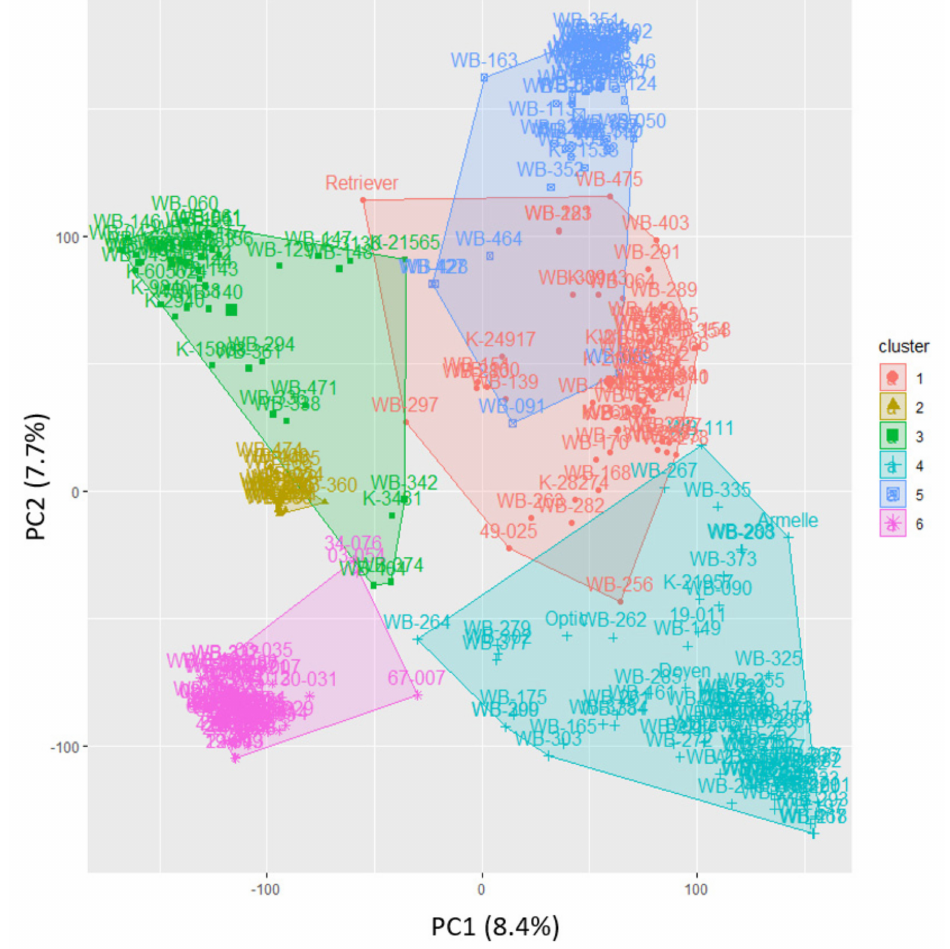
Figure 1. Principal Component Analysis (PCA) graph of individuals for the genotyping dataset composed of 115,172 single nucleotide polymorphisms (SNPs) on the collection of 312 barley acces- sions, showing the results of the cluster analysis on the first two principal components (PC1 and PC2). Figures in brackets following the axis labels indicate the percentage of the total genotypic variance accounted for by the corresponding principal component. Cluster 1: mainly six rowed landraces of European origin. Cluster 2: Ethiopian landraces. Cluster 3: mainly Asian landraces, from the Middle East to India and Korea. Cluster 4: mainly European two-rowed landraces. Cluster 5: six-rowed landraces from the Mediterranean region. Cluster 6: mainly two-rowed landraces from the Middle